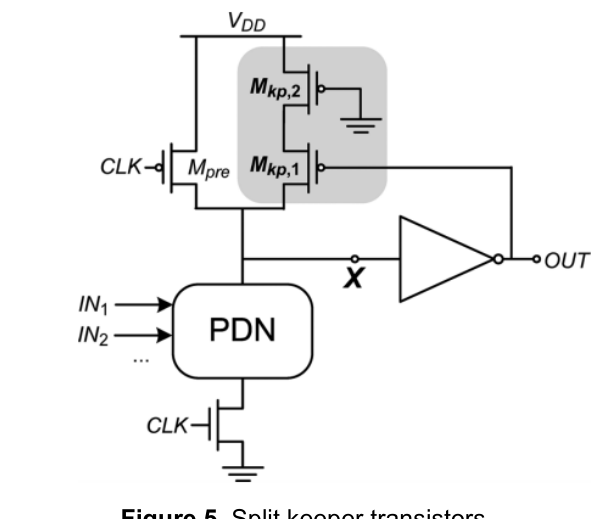
Figure 5. Split keeper transistors